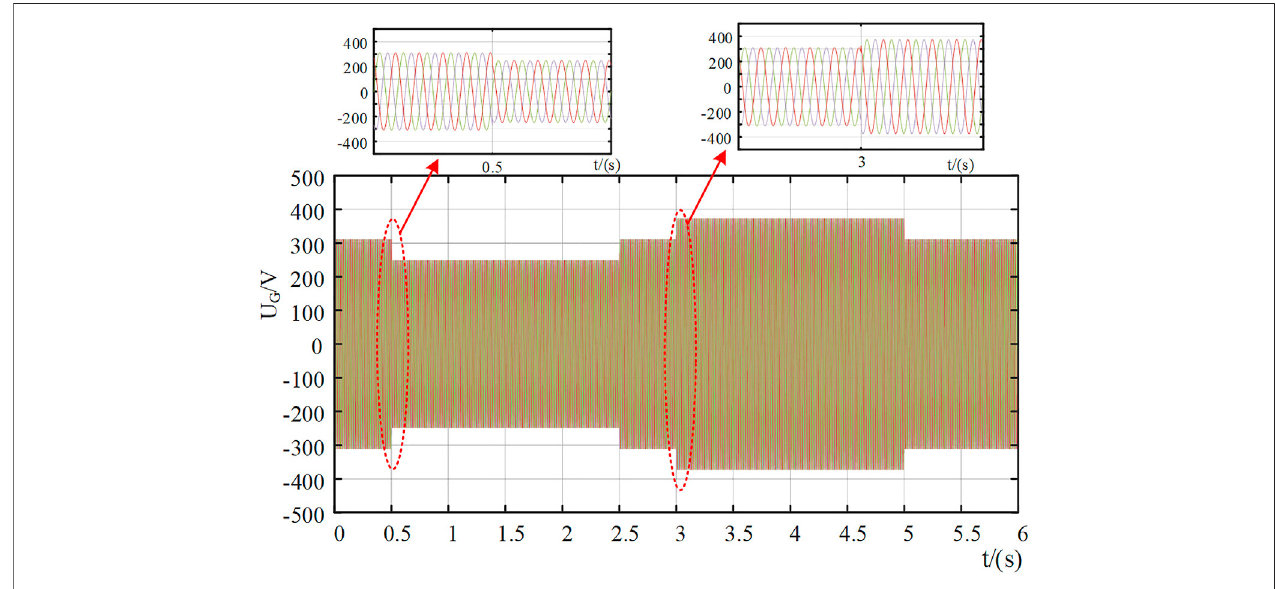
FIGURE 6 | Grid controlled node voltage.